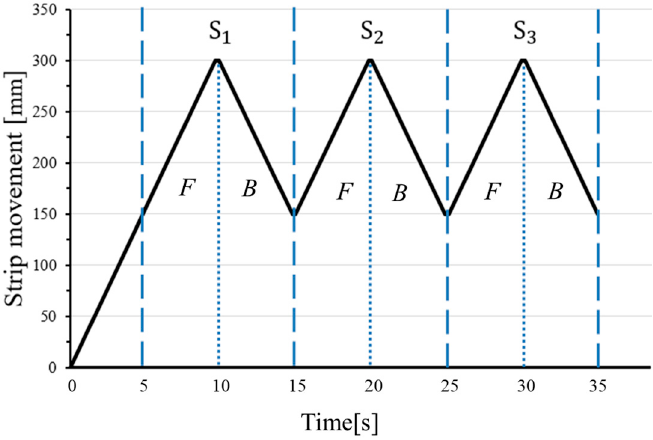
Figure 3. Strip movement variations during friction tests.